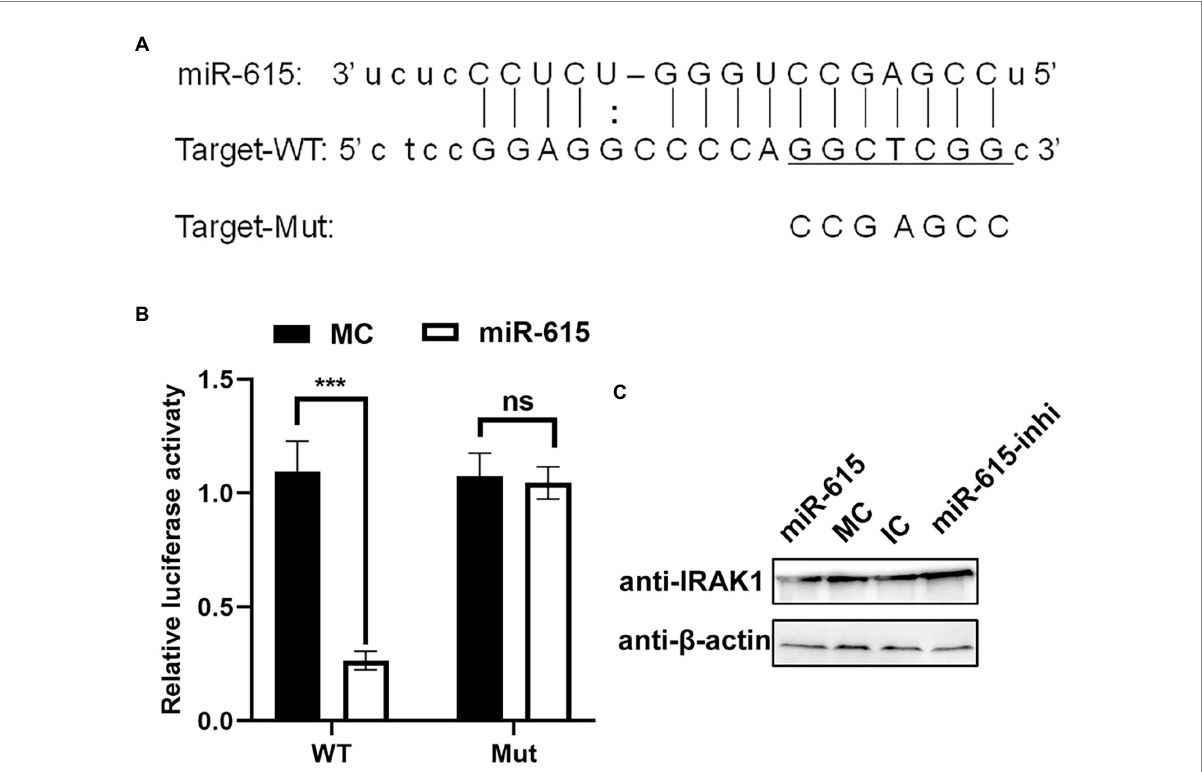
FIGURE 6 miR-615 targets IRAK1. (A) Bioinformatic prediction of the interactions between miR-615 and the 3 ′ -UTR of swine IRAK1 . For each schematic, the upper sequence is the sequence of mature miR-615, the middle sequence is the sequence in the binding site of miR-615 in the 3 ′ -UTR of swine IRAK1 , and the lower sequence is the mutated sequence of the IRAK1 3 ′ -UTR. The seed sequence is underlined. (B) Luciferase activity in 293 T cells co-transfected with miR-615 mimics (or MC) and luciferase reporter gene plasmids containing the WT and Mut 3 ′ -UTRs of IRAK1 for 48 h. Data are normalized against firefly luciferase activity. Comparisons between groups were determined using Student’s t-tests. *** p < 0.001, ** p < 0.01. (C) The level of the IRAK1 protein during transfection with miR-615 mimics or inhibitors in IECs detected using western blotting during PEDV infection. Western blotting was conducted using anti-IRAK1 antibody at 24 h post-infection